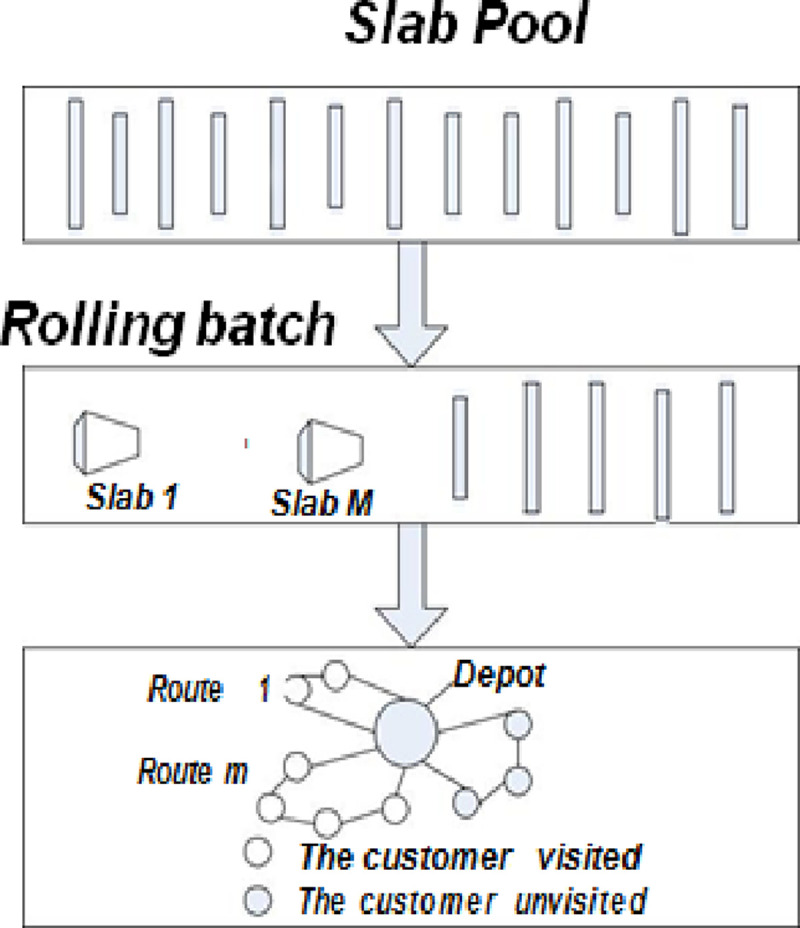
HPCVRP and HRBS.